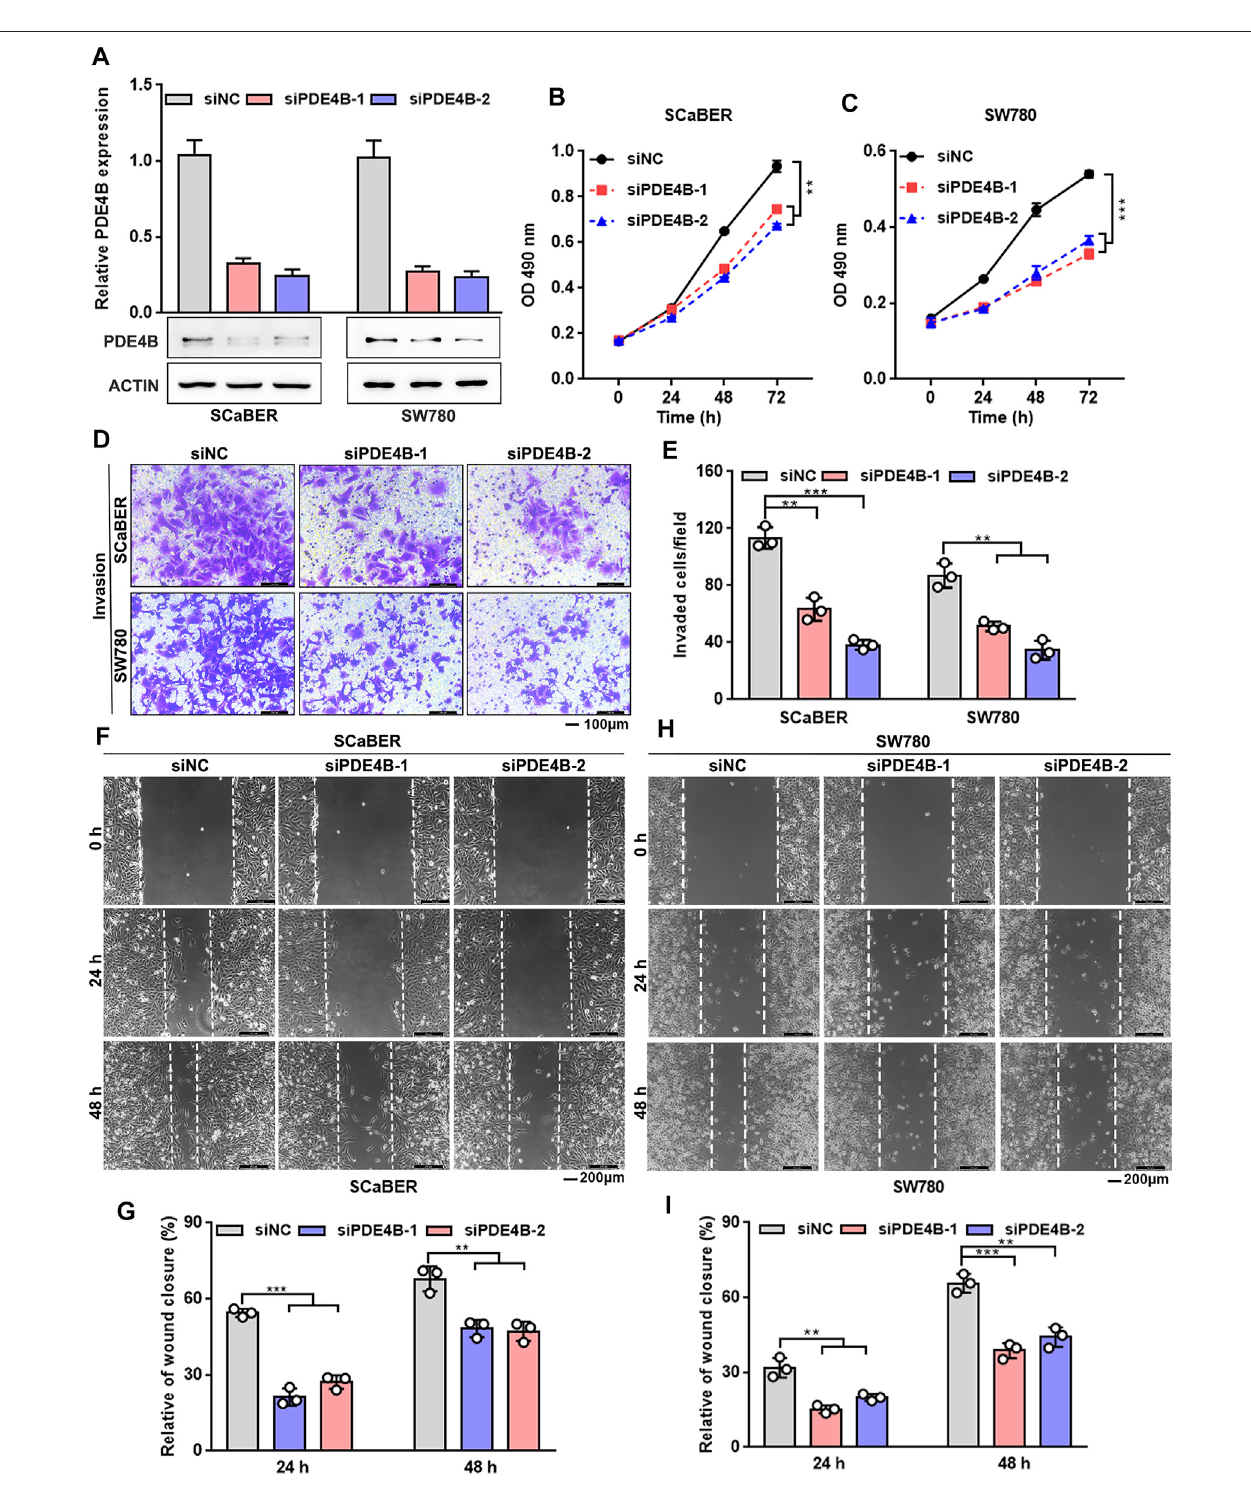
FIGURE 5 | PDE4B knockdown inhibits UBC cells proliferation and invasion. (A) PDE4B knockdown in SCaBER and SW780 cells were con fi rmed by qRT-PCR andwesternblottingaftertransfectionwithsiRNAs. (B,C) EffectsofPDE4Bknockdownoncellviability. (D – I) EffectsofPDE4Bknockdownoncellinvasionandmigration examined by transwell (D,E) and wound healing (F – I) assays. Scale bar, 100 μ m (D) and 200 μ m (F,H) . ** p < 0.01, *** p < 0.001.